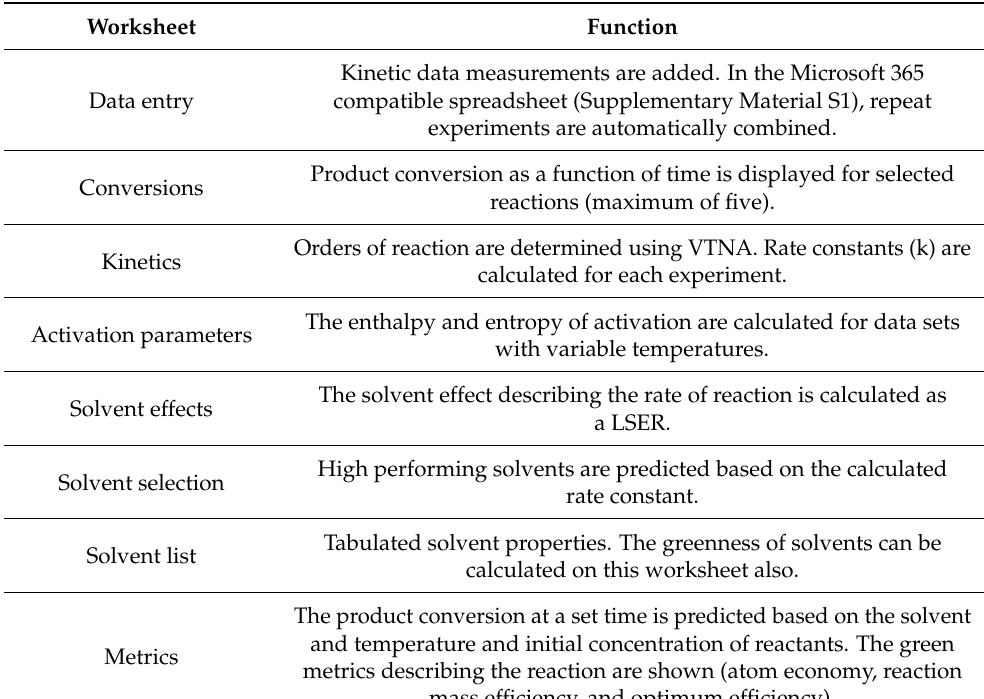
Table 1. Summary of reaction optimization spreadsheet